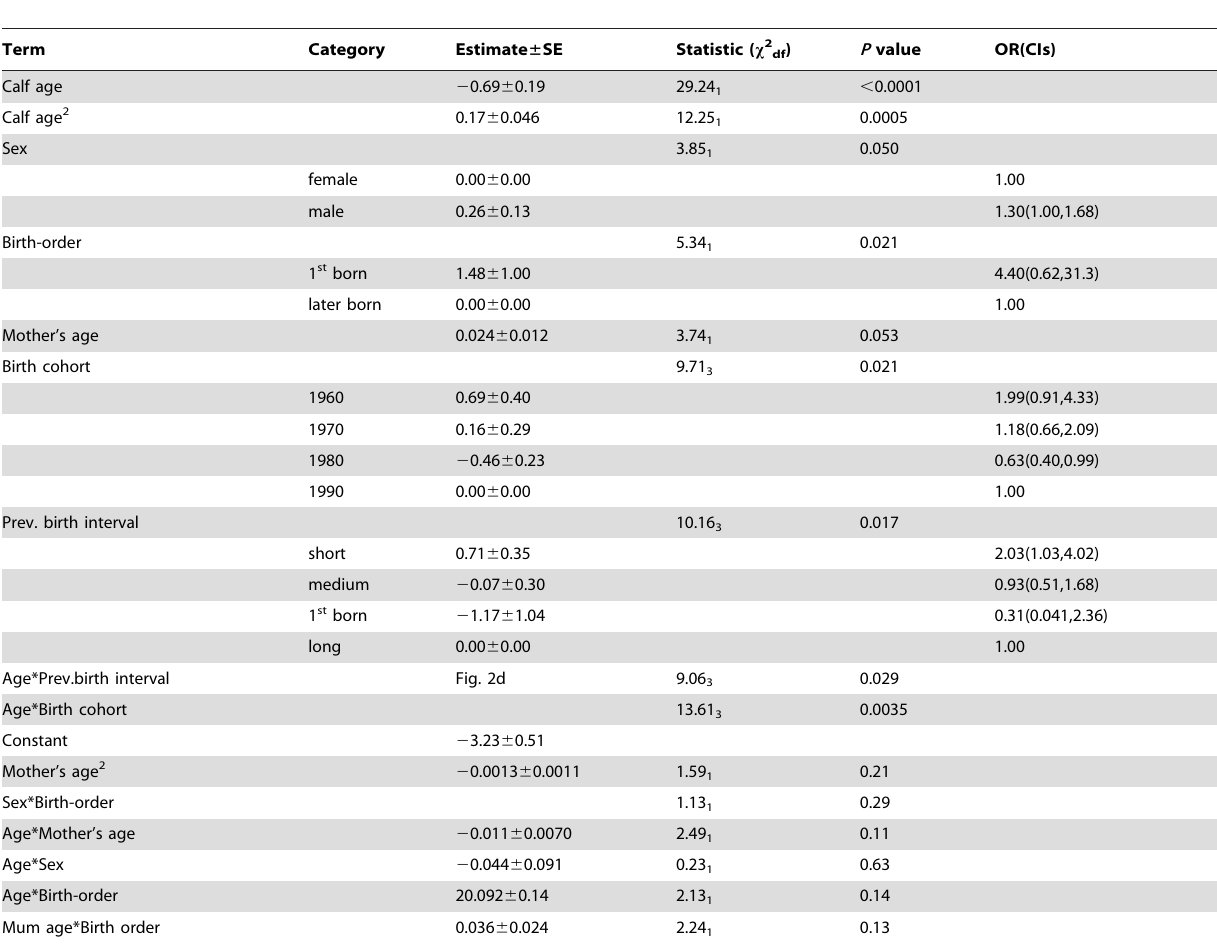
Table 3. Discrete time survival model of the Asian elephant calf mortality risk from birth to 5 years ( n = 975 calves with 4121 observations (227 deaths)).